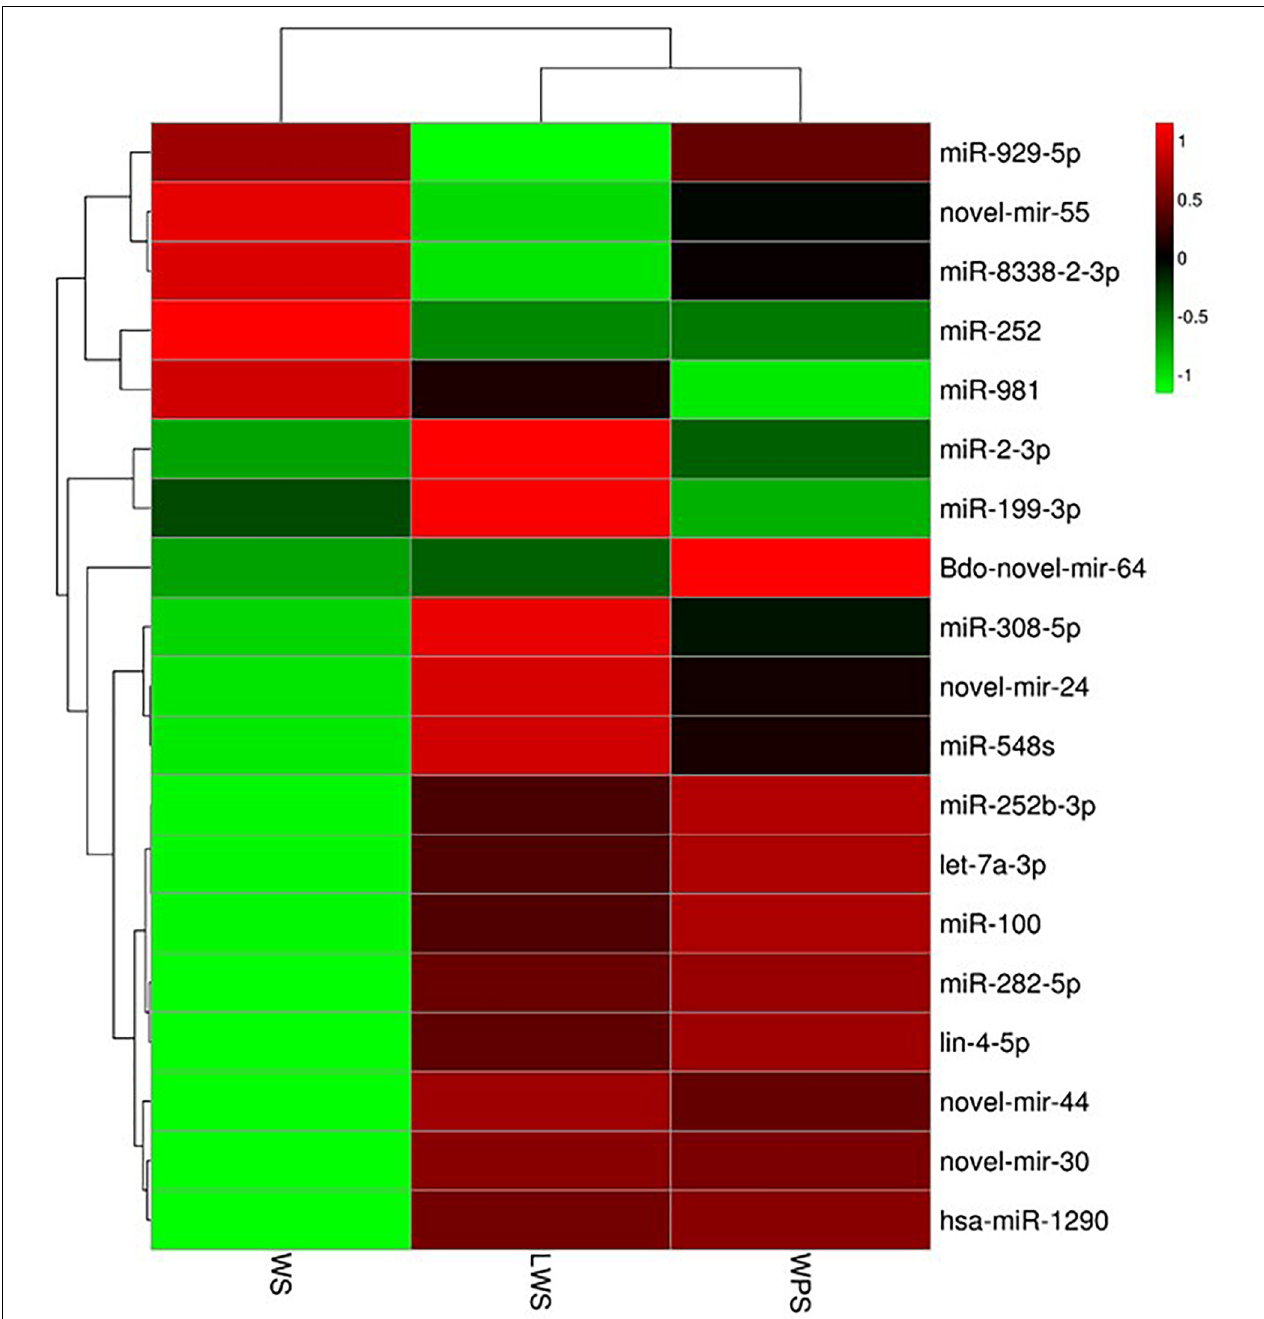
Table S5 ). By filtering the low expression miRNAs (the expression level of any one stage is less than five TPM in the three stages), a total of 19 DEMs was obtained in the current study. Three DEMs